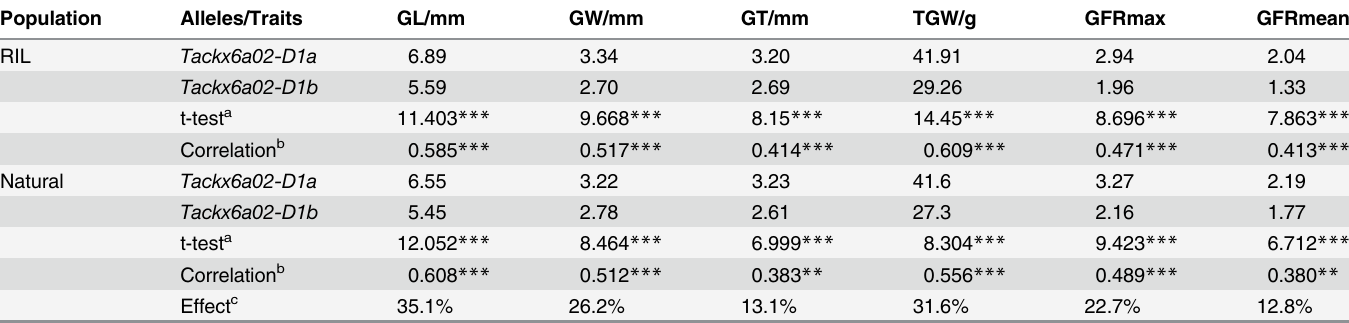
a t -test of the averages of grain traits between the two alleles of Tackx6a02 . b Correlation between allelic variation of TaCKX6a02 and grain traits among 61 wheat varieties. c Effect of allelic variation on the variability of grain traits, as estimated by R 2 based on the General Linear Model. ** indicates signi fi cant differences at P <